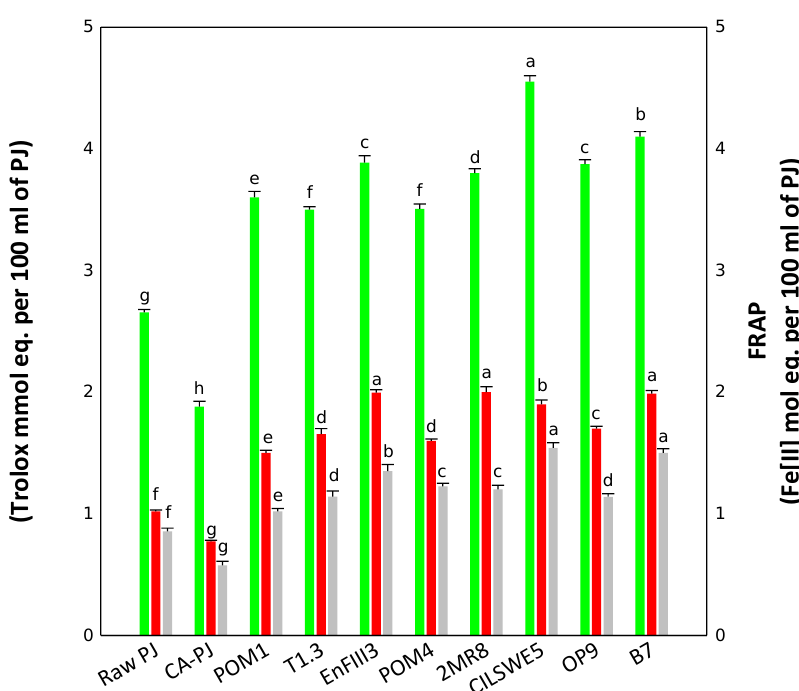
Figure 1. DPPH · (green bars) and ABTS · (red bars) radicals scavenging activities, and ferric reducing antioxidant power (FRAP) (grey bars) of raw Portulaca oleracea L. juice (Raw-PJ), chemically acidified